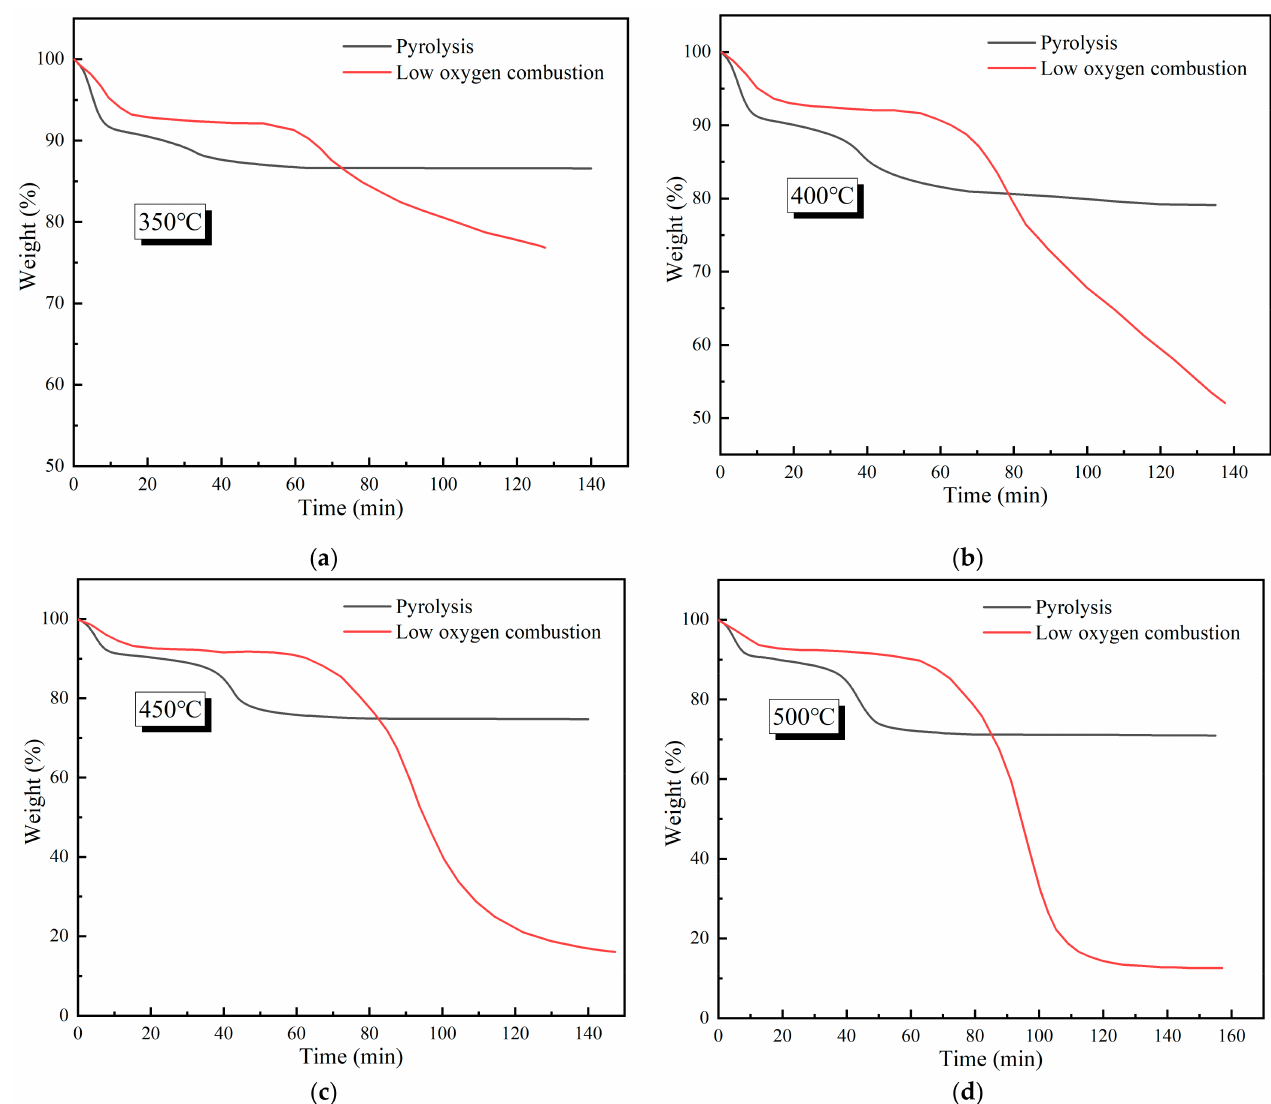
Figure 1. TG curve of pyrolysis and low oxygen combustion in different constant temperatures: ( a ) The constant temperature is 350 ◦ C, ( b ) the constant temperature is 400 ◦ C, ( c ) the constant temperature is 450 ◦ C, and ( d ) the constant temperature is 500 ◦